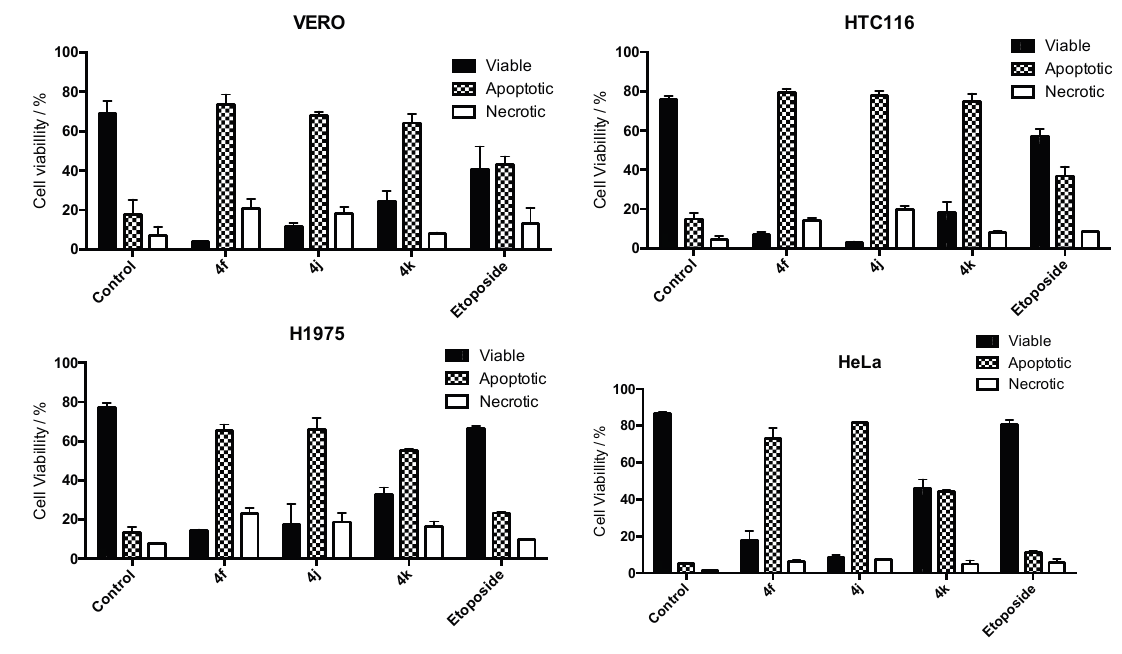
Figure 5. Viability assays of compounds 4f , 4j and 4k on cancer cell